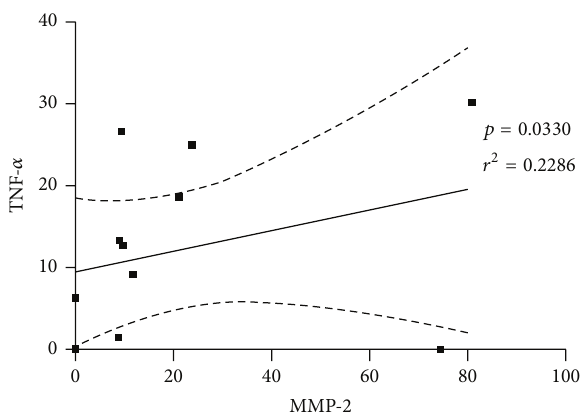
Figure 4: Correlation analysis between TNF- 𝛼 and MMP-2 mRNA from bone biopsies of control and periodontal disease (PD) patients. The samples were subjected to qRT-PCR, SYBR green method. Data are reported for control ( 𝑛 = 8 ) and PD group ( 𝑛 = 12 ) tested individually. 𝑝 = 0.0036 , 𝑟 𝑠 = 0.6190 , Spearman